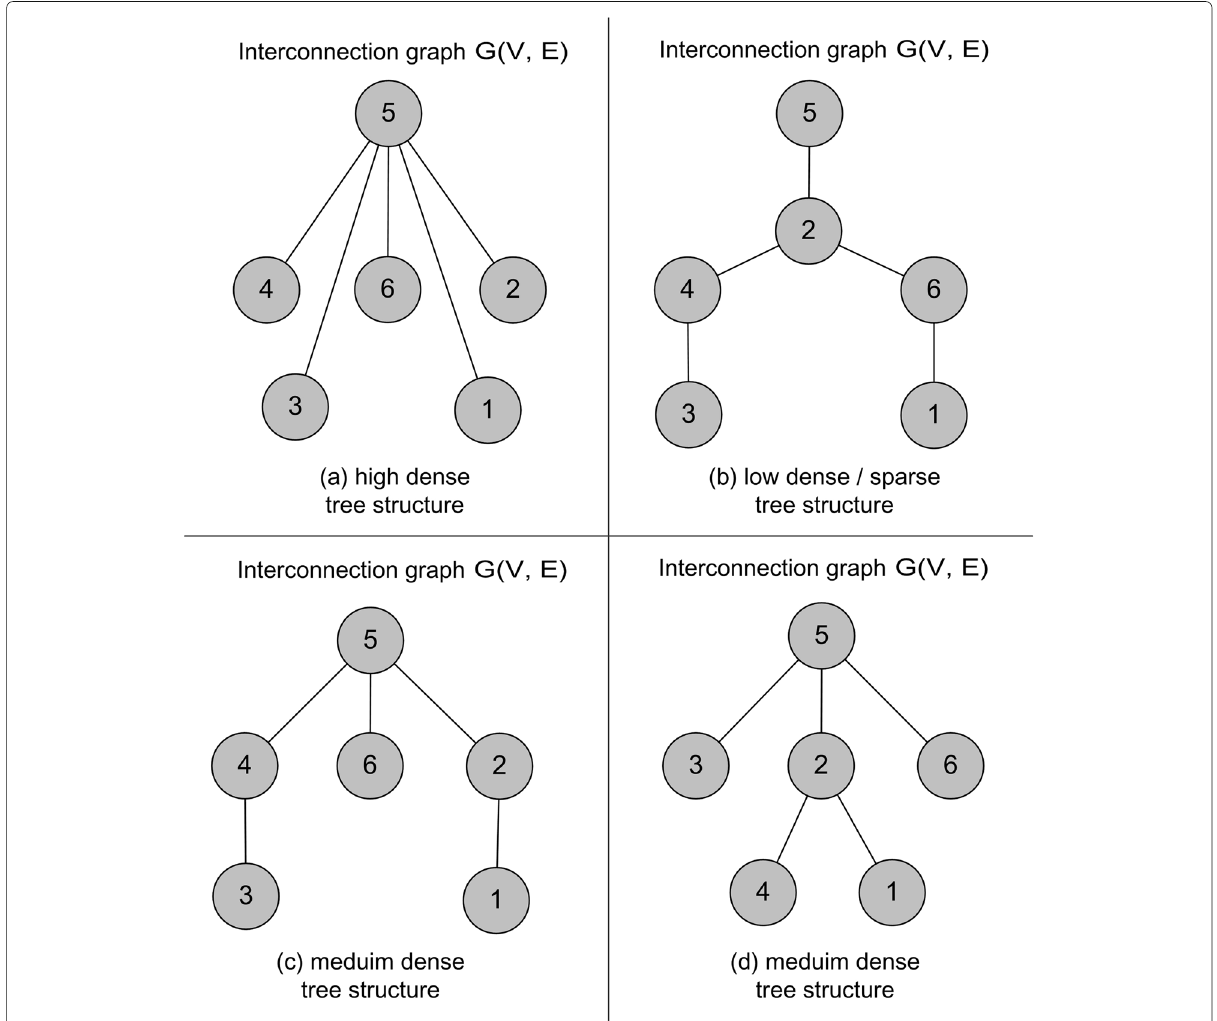
Fig. 14 Effect of tree density on standard TBC/MTBC and proposed advanced R-TBC/RTA consistency approaches in a hybrid cloud DBMS environment